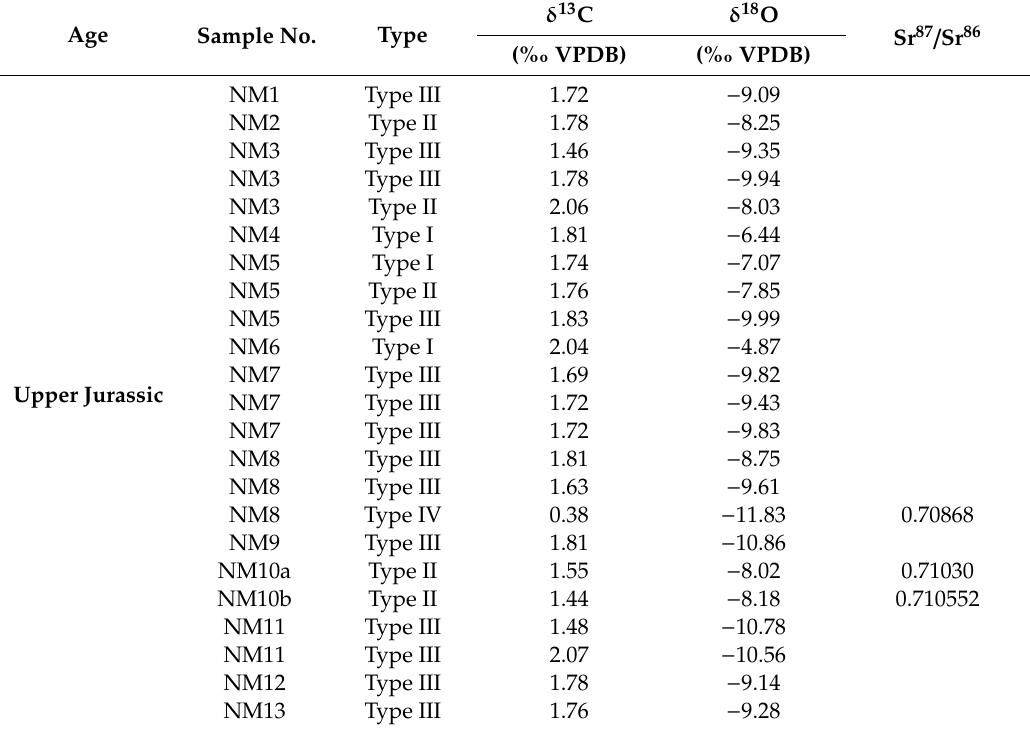
Table 2. δ 13 C (% VPDB), δ 18 O (% VPDB), (Sr 87 / Sr 86 ) values of selected samples from Triassic–Jurassic succession ( n = 100). Type I = D1 T / J and D2 T / J . Type II = SD1 T / J and SD2 T / J . Type III = SD3 T / J , SD4 T